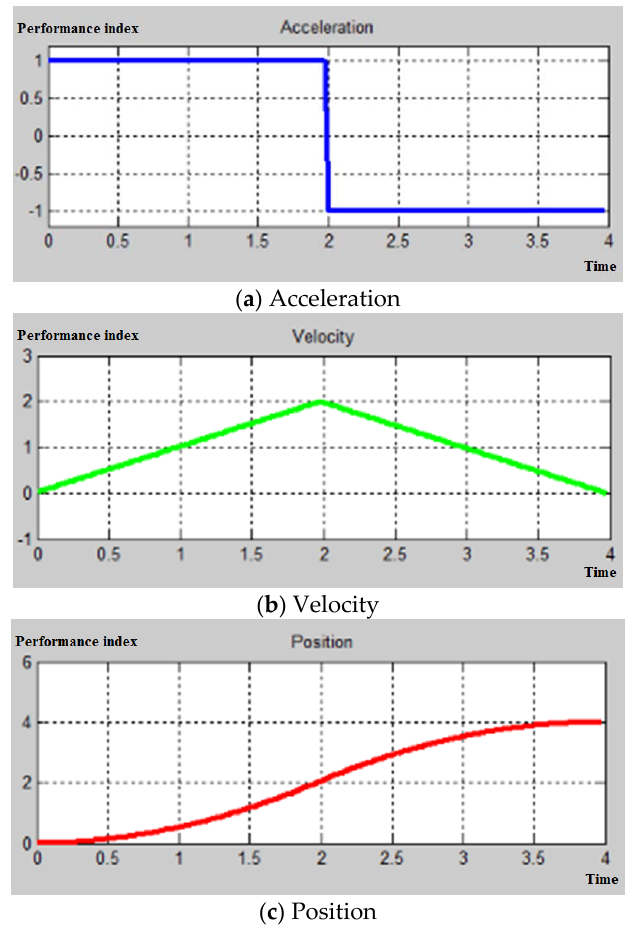
Figure 16. Rainbowchain MATLAP performance data. ( a ) Acceleration; ( b ) Velocity; ( c ) Position.